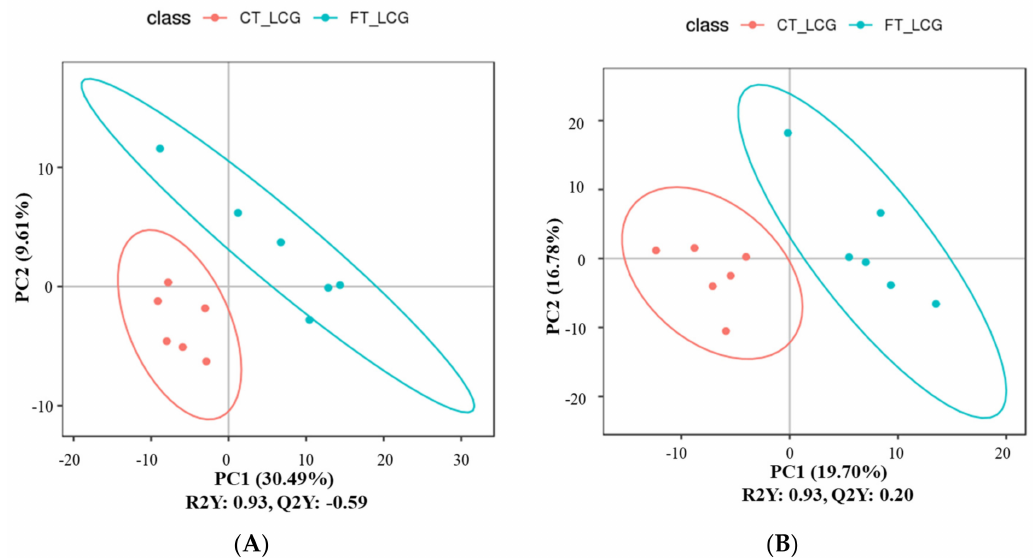
Figure 6. PLS-DA score scatter plots (( A ): positive mode; ( B ): negative mode). The sample’s score on the first principal component is represented by the abscissa, while the ordinate represents the sample’s score on the second principal component. R2Y is the model’s interpretation rate, and Q2Y is used to assess the PLS-DA model’s predictive power.